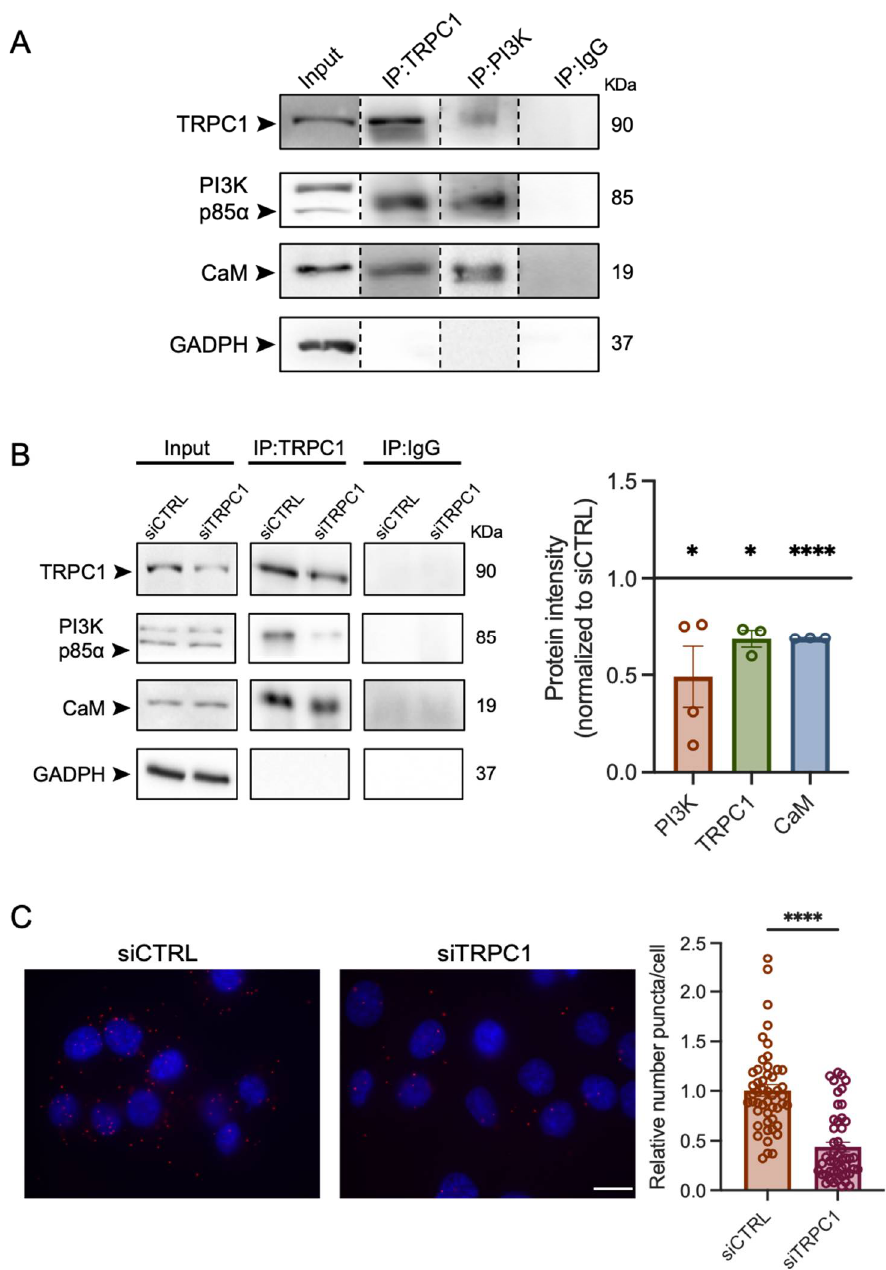
Figure 7. TRPC1 forms a complex with the PI3K p85 α subunit and CaM, which is abolished upon TRPC1 knockdown. ( A ) Representative western blot analysis of co-immunoprecipitation of TRPC1 and PI3K p85 α subunit with CaM in non-transfected PANC-1 cells. ( B ) Representative western blot analysis of co-immunoprecipitation of TRPC1 with PI3K p85 α and CaM in transfected PANC-1 cells (left panel). Quantification of western blot analysis compared to siCTRL represents the effect of TRPC1 KD on the protein interaction (right panel) ( n = 3–4). * and **** indicate p < 0.05 and 0.0001, respectively. ( C ) Representative images of proximity ligation assay (PLA) in transfected PANC-1 cells (left panel). Quantification of PLA where siTRPC1 is compared to the relative number of siCTRL ( n = 3. At least 20 images were analyzed for each experiment, see material and methods for details) (right panel). **** indicates p < 0.0001,